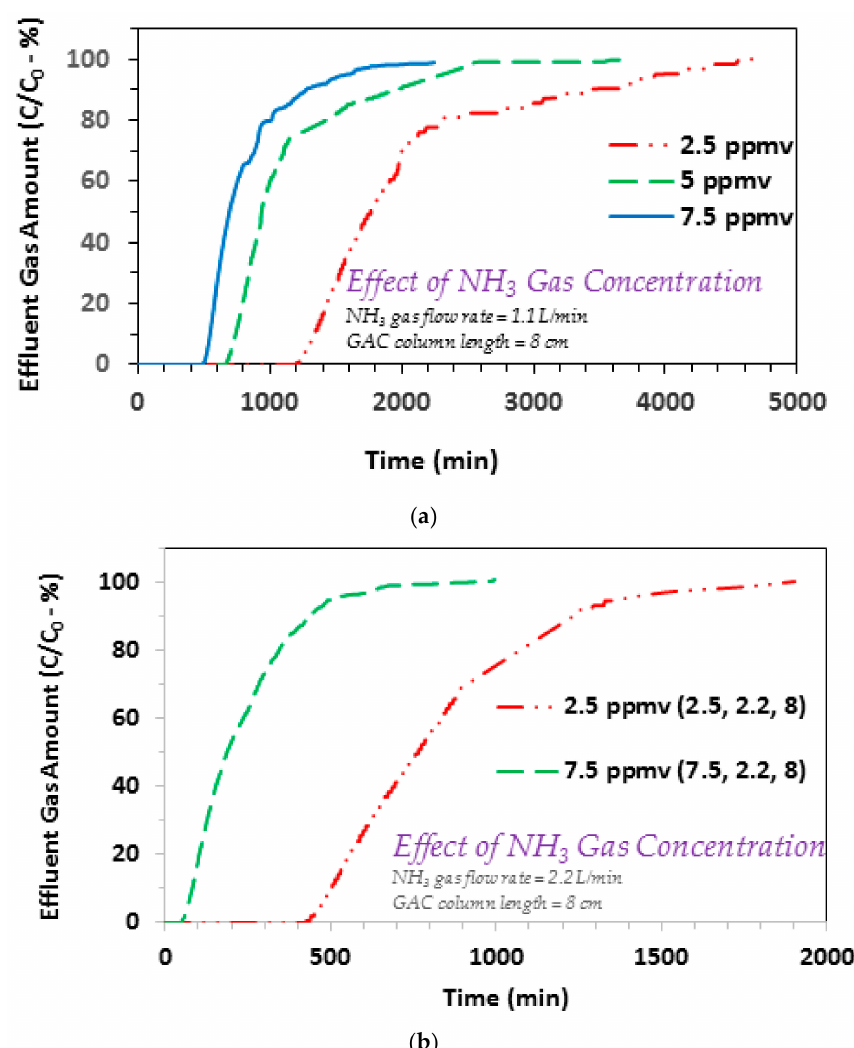
Figure 2. ( a ) E ff ect of influent ammonia gas concentration on the adsorption breakthrough curve profile of ammonia gas on to GAC produced from date palm pits. ( a ) GAC SSA BET = 822 m 2 / g and average pore width = 23.01 Å; ammonia / NH 3 gas flow rate = 1.1 L / min; influent ammonia / NH 3 gas concentrations 2.5, 5, and 7.5 ppmv; GAC column length = 8 cm; GAC bed dia. 6.35 mm. ( b ) GAC SSA BET = 822 m 2 / g and average pore width = 23.01 Å; ammonia / NH 3 gas flow rate = 2.2 L / min; influent ammonia / NH 3 gas concentrations 2.5, and 7.5 ppmv; GAC column length = 8 cm; GAC bed dia. 6.35